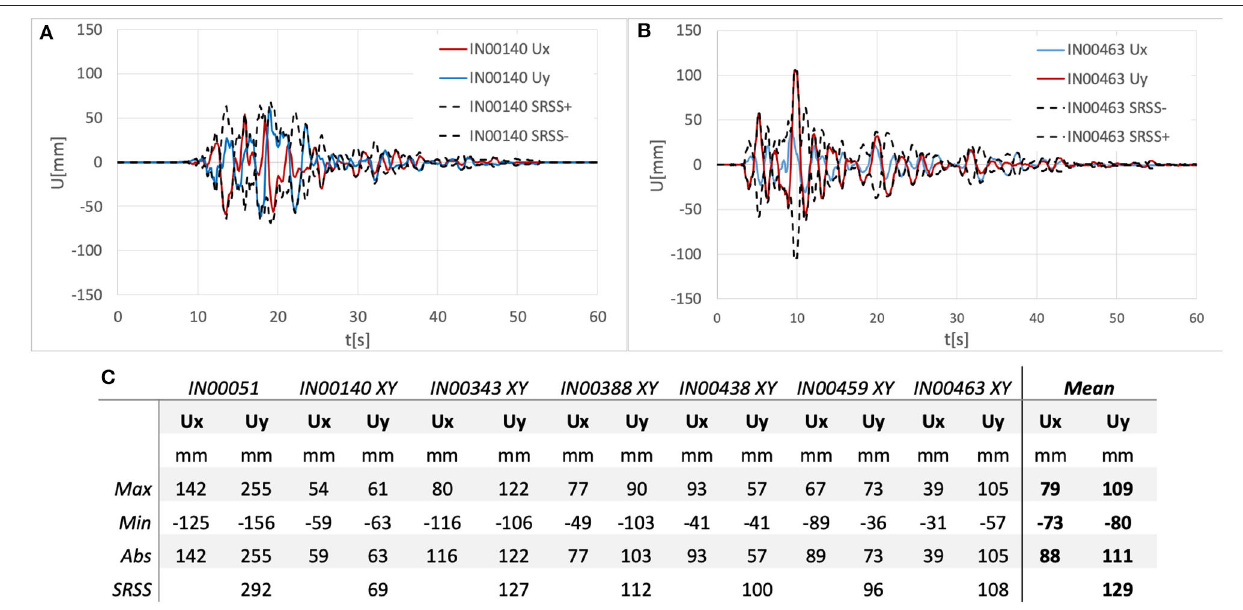
FIGURE 13 | NL dynamic analyses on the case study structure. (A) Displacement history for GM IN00140. (B) Displacement history for GM IN00463. (C) Maximum, minimum, absolute, and resultant (SRSS) values for each GMs and mean